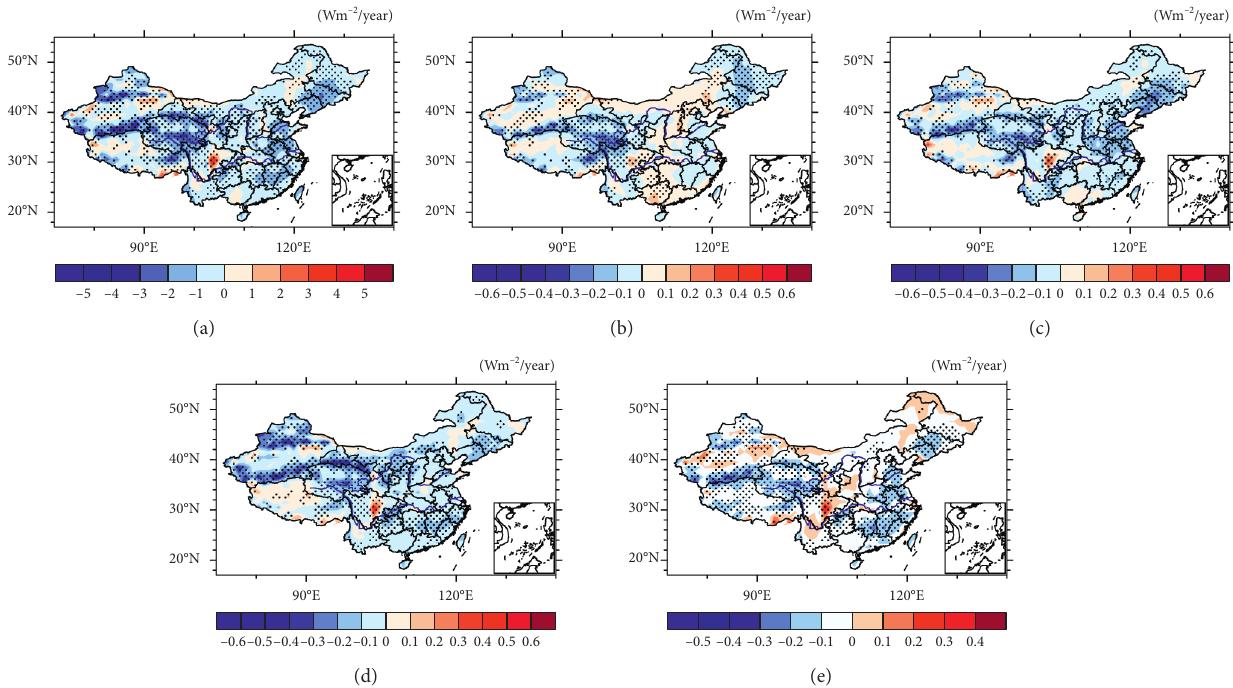
Figure 4: Distribution of annual and seasonal linear LER trends (Wm − 2 ) in China under clear-sky conditions during 2001–2016: (a) annual, (b) spring, (c) summer, (d) autumn, and (e)